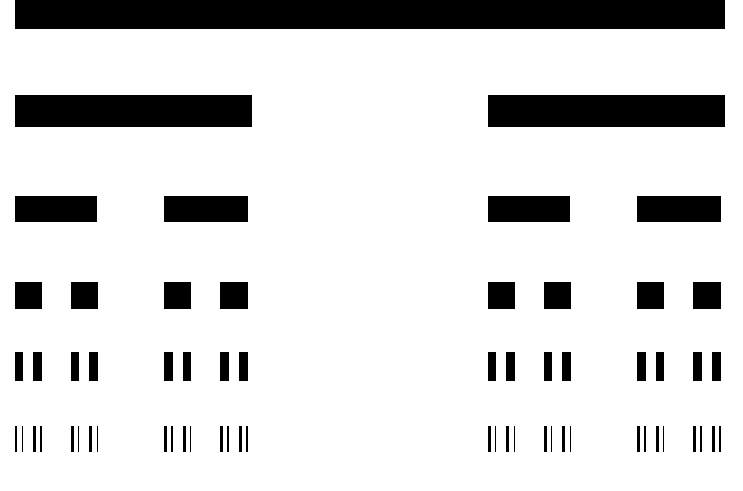
Figure 3. Cantor